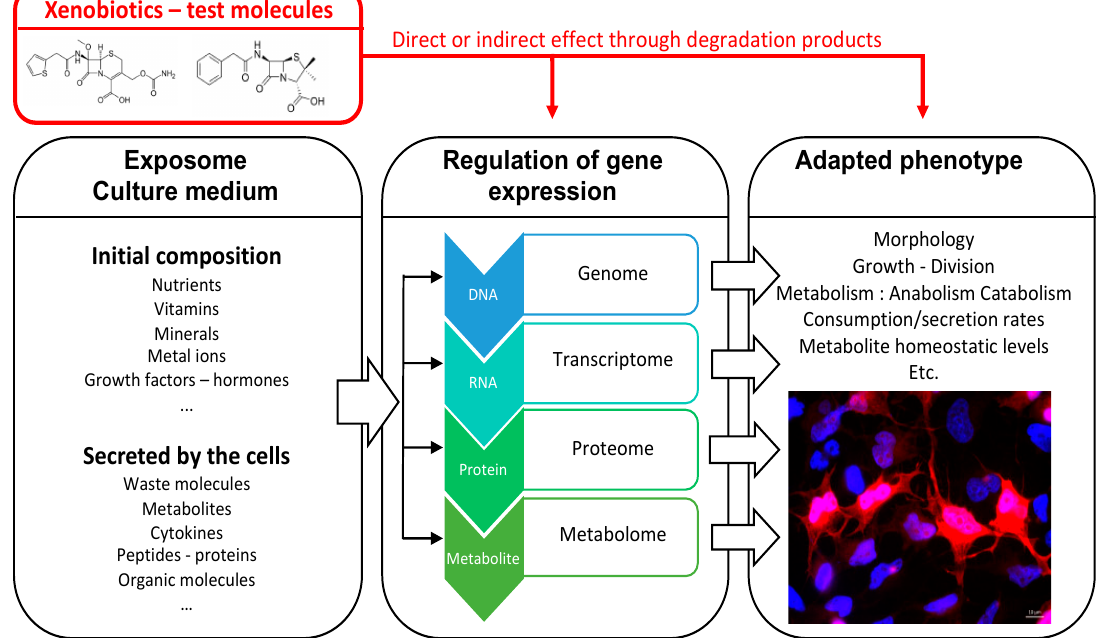
Figure 1. Cells are constantly exposed to chemical stimuli through their growth medium. They adapt their molecular machinery to their environment by constantly adjusting all levels of gene expression regulation. Like other metabolites, xenobiotics can act at every level of regulation from the genome to the metabolome to modulate the organism’s phenotype, underlying the translational value of -omics studies. The study of metabolite levels is a sensitive indicator of xenobiotics biological activities.